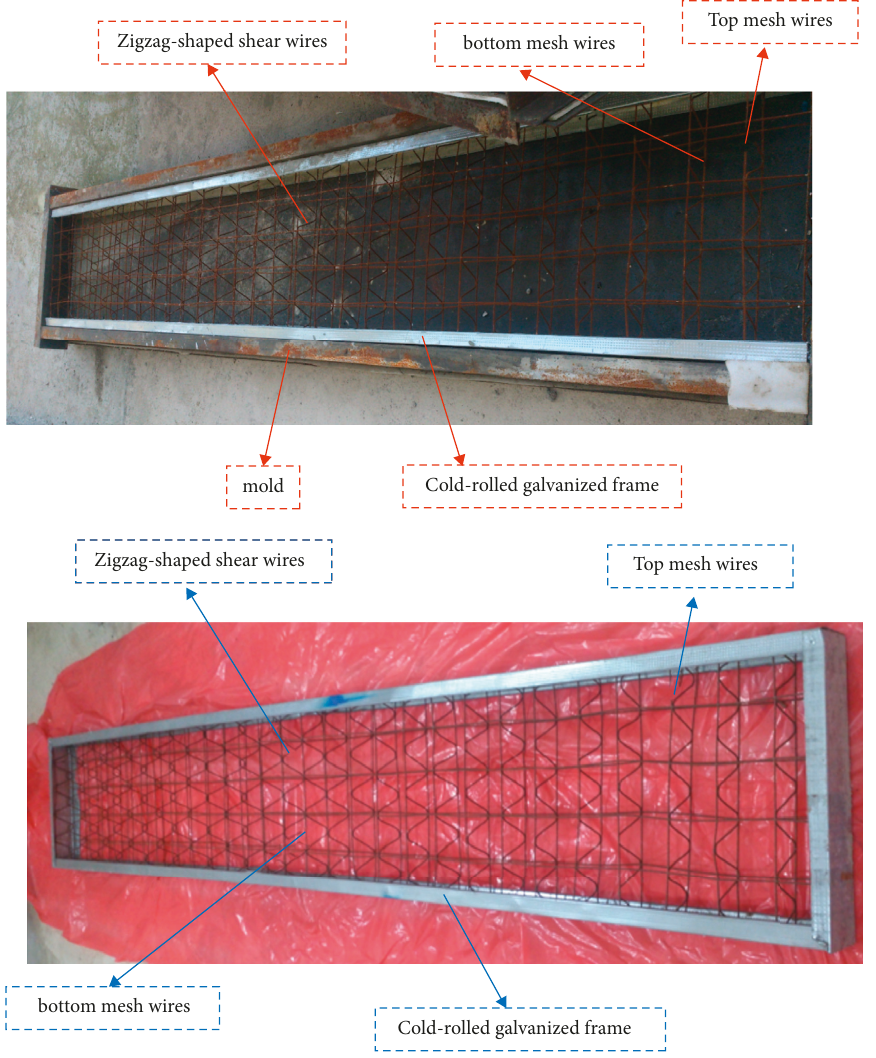
Figure 2: The mold for making the combined composite